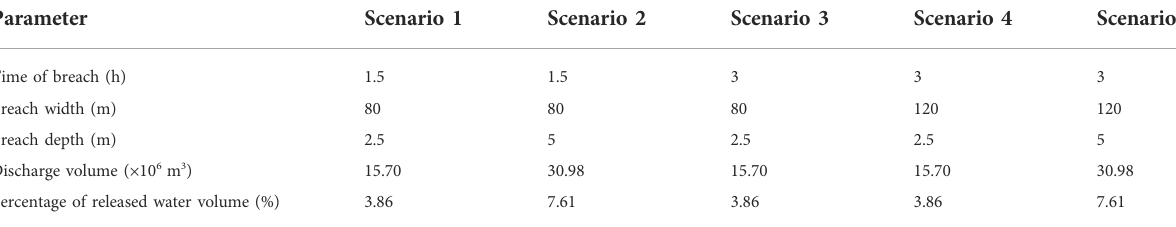
TABLE 3 Model parameters for different GLOF scenarios.